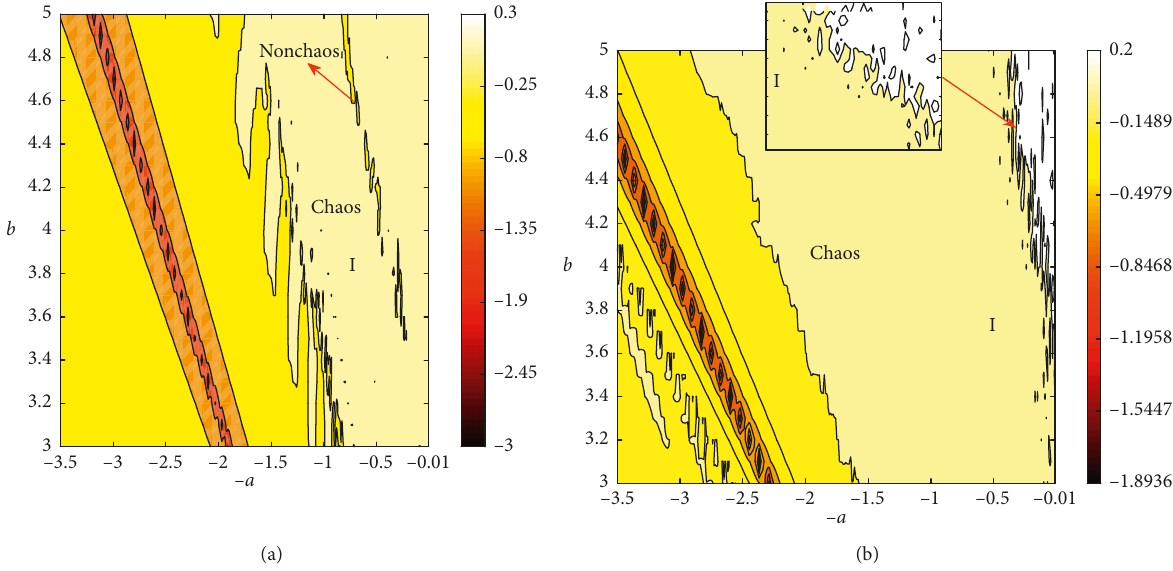
Figure 8: (a) The 2D LE diagram showing the largest Lyapunov exponent ( λ diagram showing the largest Lyapunov exponent of the ACCM-Ikeda TD system in the ( a − b ) space.